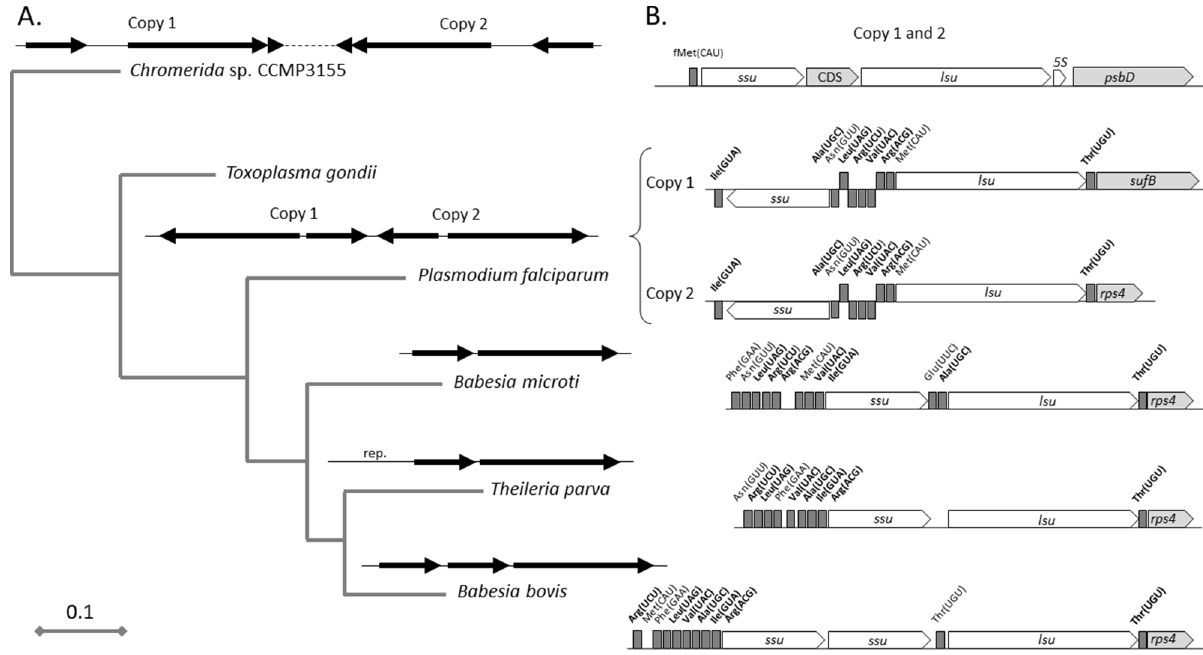
Figure 6. Organization and evolution of the rDNA region in the apicoplast genome of B.microti and other apicomplexa. A. Phylogenetic analysis based on ssu and lsu genes. The tree was obtained using the maximum-likelihood method with (Bootstrap over 90%). Genomic organization of rDNA regions in the apicoplast or chloroplast genomes is given on top of each branch. B. Gene organization of the rDNA regions. The tRNA genes that are present in all apicomplexan genomes are shown in bold. Scale bar represents the number of substitutions per site. doi:10.1371/journal.pone.0107939.g006 which are transcribed in the same orientation (Fig. 6). In this cluster consists of two sets of ssu and lsu genes in opposite orientation (Fig. 6). Gene content and gene order in this cluster Chromera sp., T. gondi and P. falciparum apicoplast genomes,